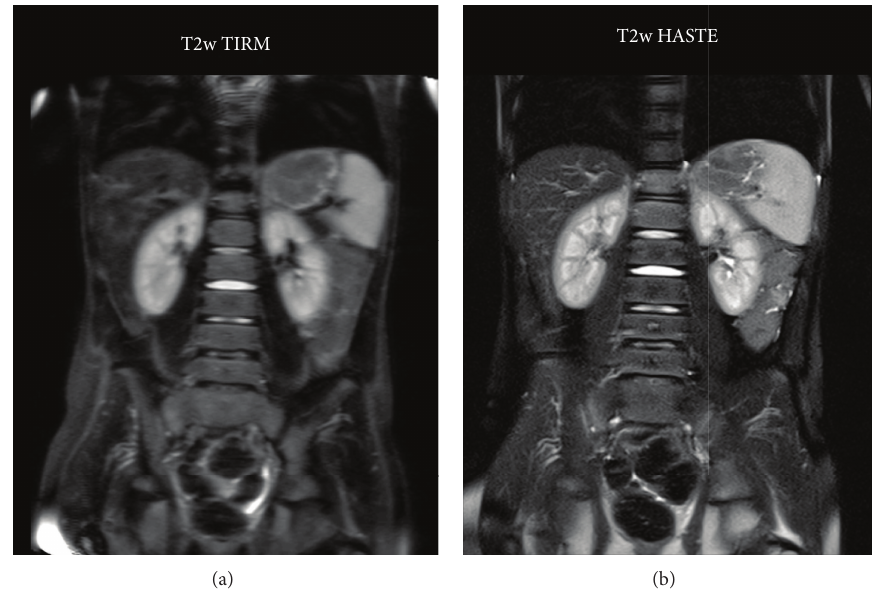
Figure 2: Coronal T2w TIRM (a) and high-resolution T2w HASTE FS (b) imaging in an 8-year-old girl with chronic abdominal pain and normal abdominal ultrasonography. In the absence of any pathological findings, the TIRM image, owing to the long repetition time, is considerably blurred by motion artefacts in the restless and continuously shifting patient. Repeating the T2 TIRM sequence did not improve image quality. HASTE imaging does not show any motion artefacts and clearly depicts bony structures including the lower thoracic and lumbal spine as well as the abdominal organs. Incomplete saturation of fatty tissue signal towards lower image margin is more noticeable with HASTE than with TIRM imaging. Image quality was graded as IQ = 2 (TIRM) and IQ = 4